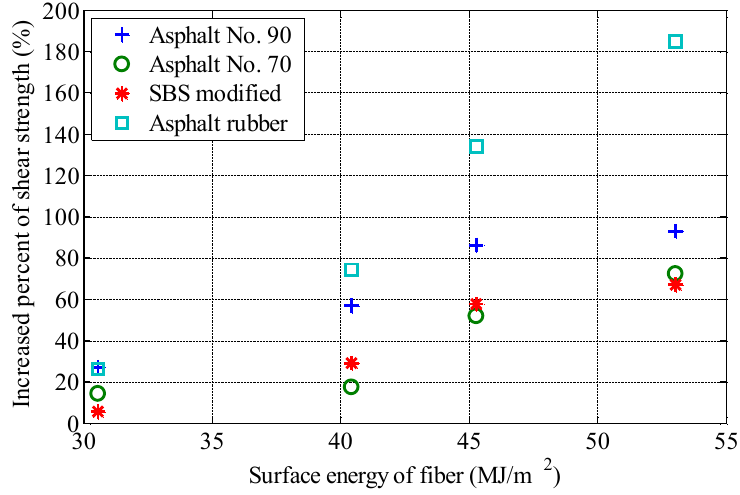
Figure 5. Relationship between surface energy of fiber and increase percent of shear strength.